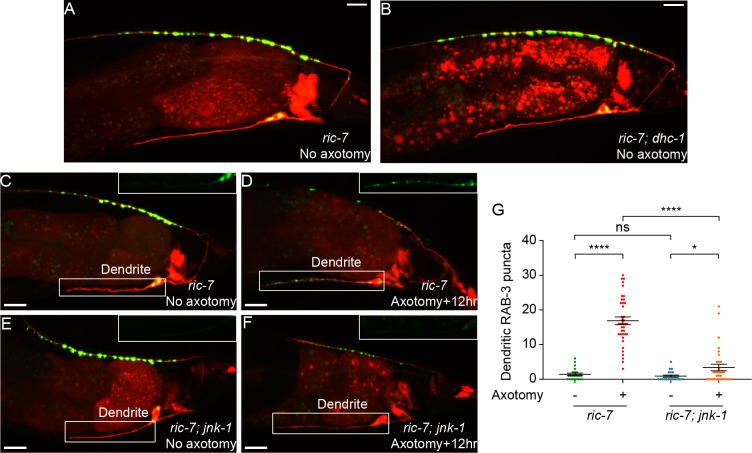
DA9 in dhc-1(js319) animals develops normally and loss of JNK-1 rescues RAB-3 mis-localization in DA9 dendrite 12 hr after axotomy.(A–B) RAB-3::GFP and mCherry labeling of DA9 in intact ric-7(n2657) and ric-7(n2657); dhc-1(js319) animals (2-day-old adults). Scale bars = 10 μm. (C–F) RAB-3 localization to the dendrite inArxiocn-7ti(pn2657) and ric-7(n2657); jnk-1(gk7) animals with and without axotomy 12 hr after axotomy. Magnified GFP channels are shown at the top right corner. Scale bars = 10 μm. (G) Quantification of dendritic RAB-3 puncta number in animals in (C–F). Mean ± SEM. *p<0.05; ****p<0.0001; ns, not significant. Unpaired t test.